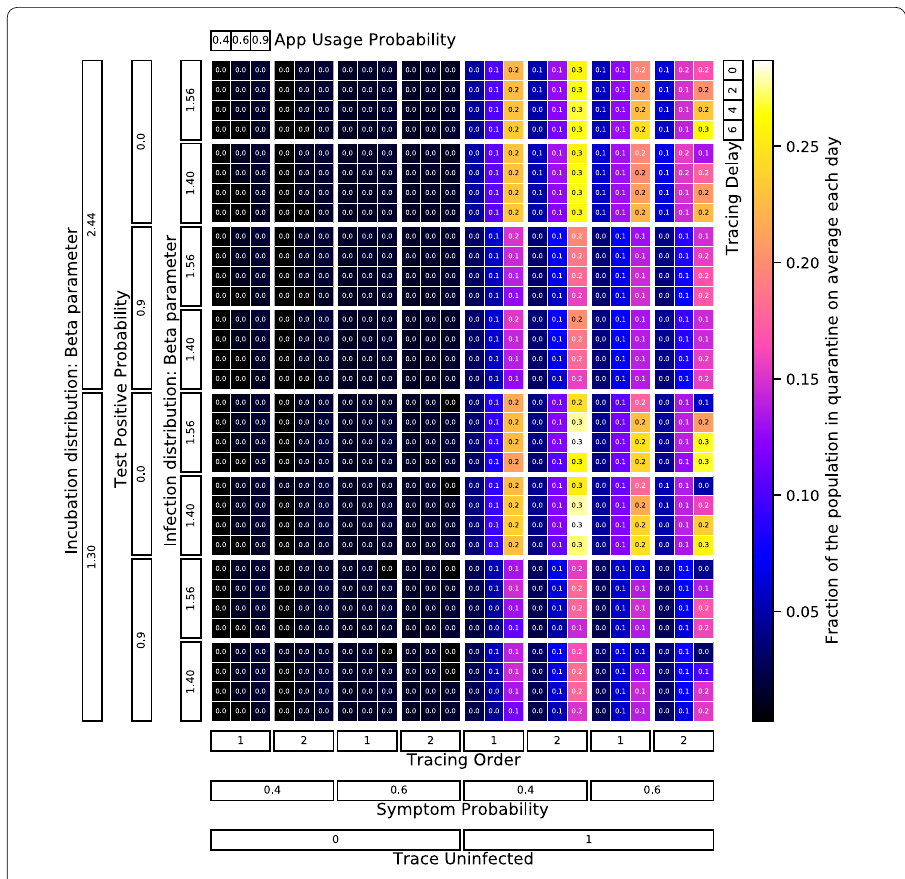
Figure 30 The fraction of the population quarantined on average over one year of the outbreak is shown for all combinations of parameters in the timing and delay parameter